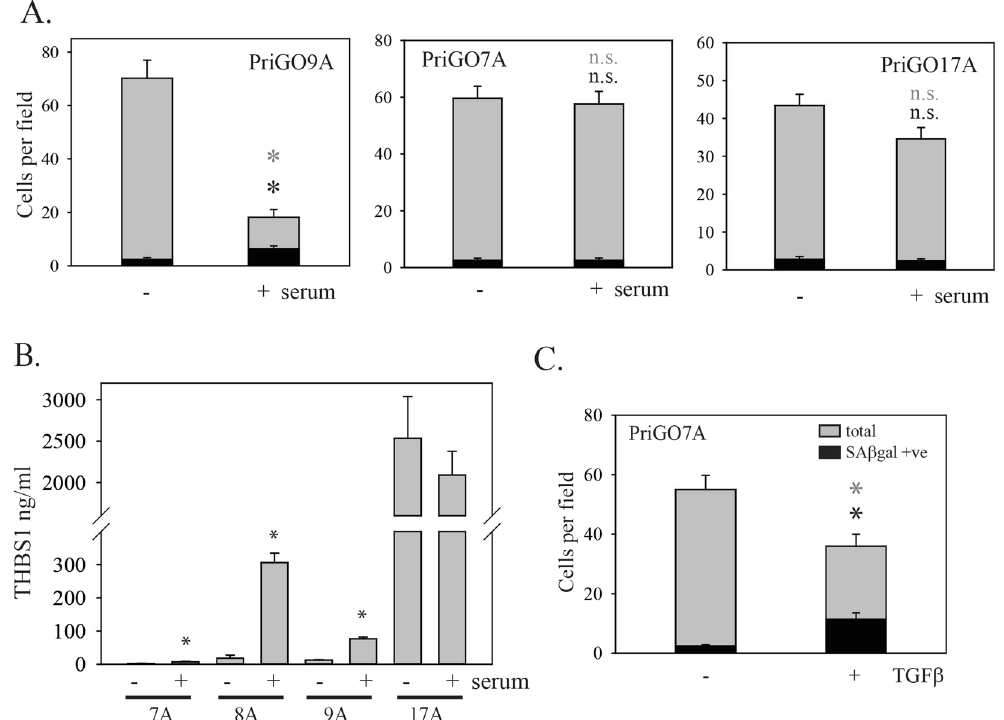
Figure 7. Heterogeneity of responses to serum in cells from different glioblastoma patients. ( A ) PriGO9A, PriGO7A and PriGO17A cells were treated with 10% serum and assayed for SA β gal activity as described in Fig. 1. Statistical significance was determined using two-tailed t tests. ( B ) PriGO cells from different patients were treated without or with serum for 24 h. Conditioned media was then collected and analyzed for levels of thrombospondin by ELISA. Data shown are mean ± SD for triplicate analyses for each condition and are corrected for background of either media alone or media plus serum, as well as corrected for cell number at the time of collection of conditioned media. Statistical significance was determined using the Mann-Whitney Rank Sum test. ( C ) PriGO7A cells were treated without or with 20 ng/ml TGF β . Seven days later cells were fixed and stained for SA β gal activity. Data are from analysis of five random fields per condition. Error bars show the standard error. Statistical significance was determined using two-tailed t-tests. For ( A–C ), * indicates p < 0.05 and n.s. indicates p > 0.05 compared to no TGF β